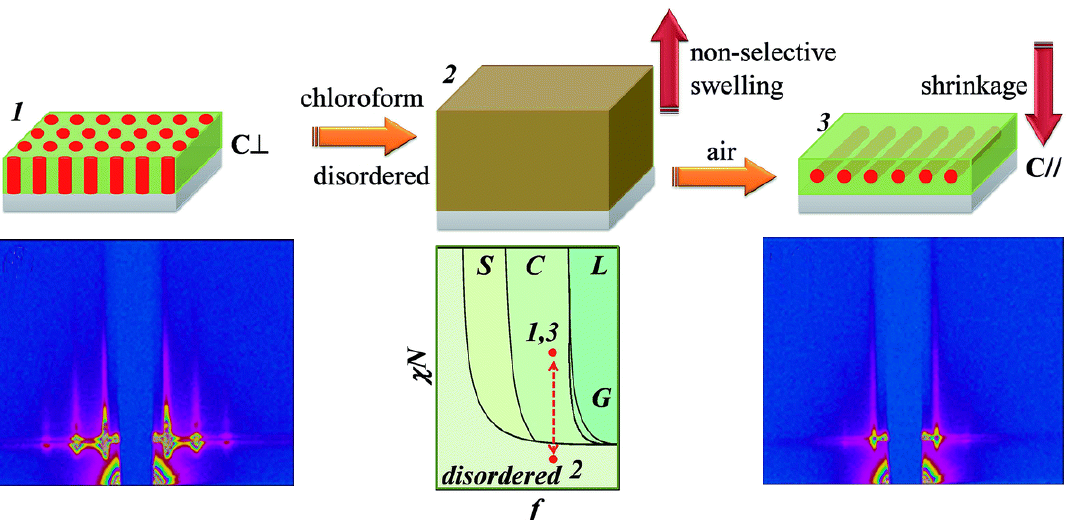
Figure 22. Schematic representation of microdomain reorientation during swelling of a block copolymer thin film in a non-selective solvent (chloroform) vapors together with the GISAXS pattern at the initial (1) and the final states (3). Phase diagram in the center of the bottom raw shows the pathway during the swelling-drying procedure. Adapted from Gowd et al. [206] with permission from the Royal Society of Chemistry c 2014. (cid:13)